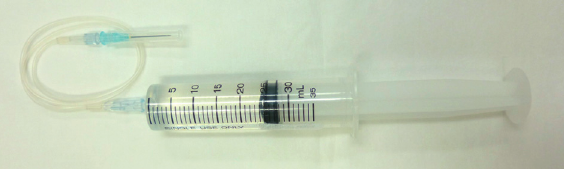
Figure 2: Syringe, extension tube, and